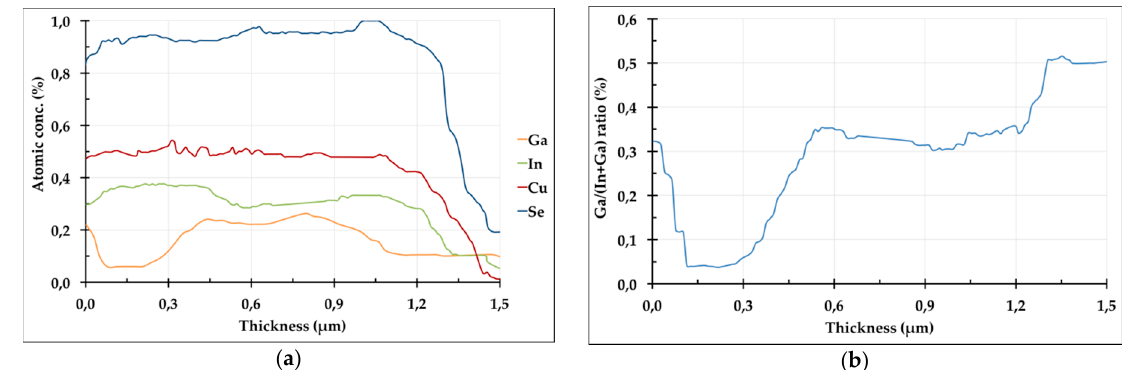
Figure 8. ( a ) SIMS in-depth profile spectrum of the CIGS layer after selenization of InSe–GaSe–Cu–GaSe stacked layers. To make the spectrum more legible, the Mo signal was removed; ( b ) Detail of the Ga/(In+Ga) ratio along the CIGS layer thickness.